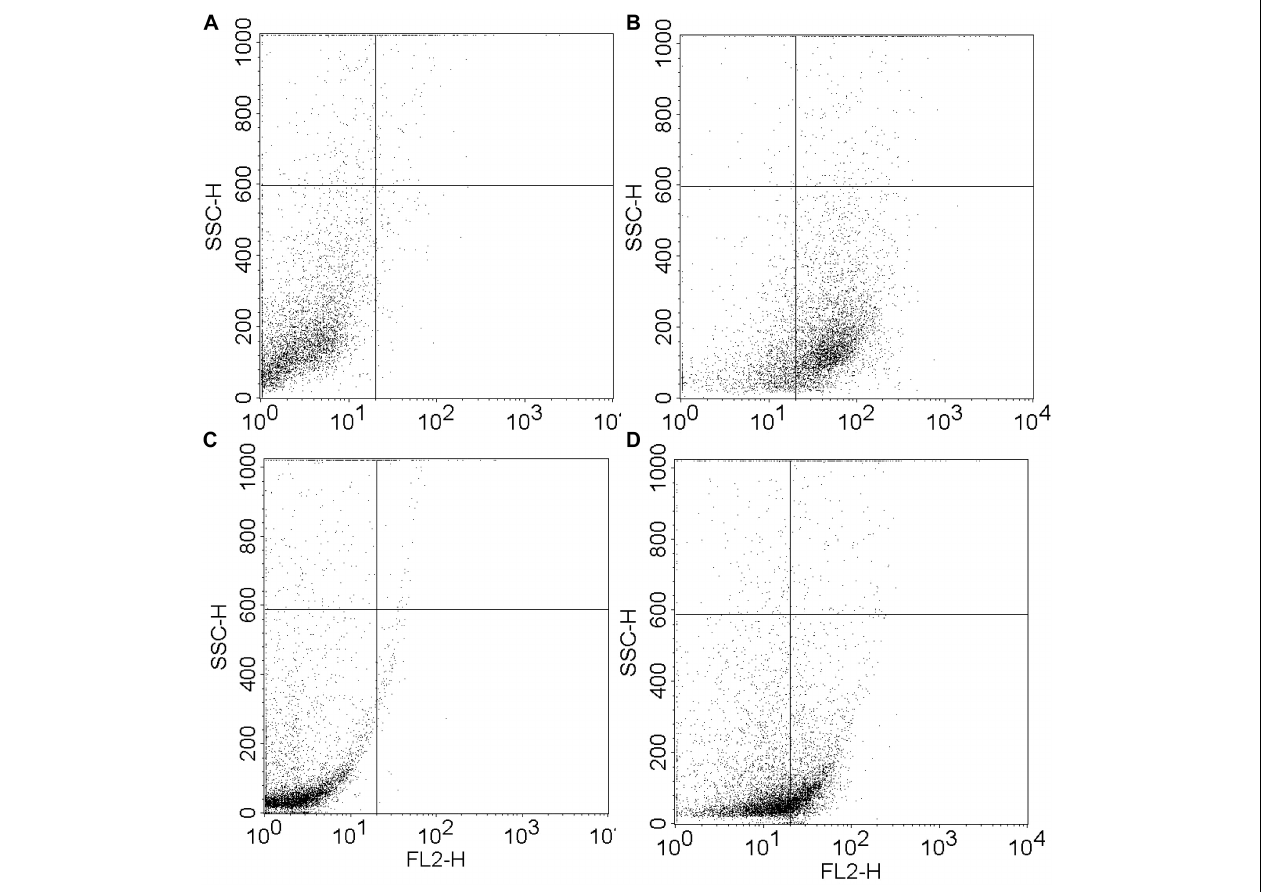
FIGURE 3 | Fluorescence activated cell sorter (FACS) analysis of hydrogel-treated S. aureus and P. aeruginosa at a concentration of 16 µ g ml - 1 . Dead cell percentages were calculated as 62.54% for S. aureus (A,B) and 34.88% for P. aeruginosa (C,D) .